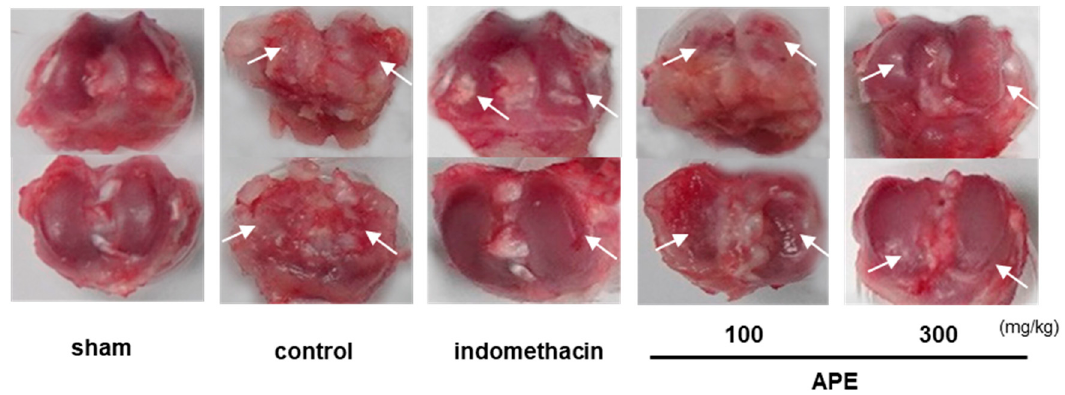
Figure 3. Photographic images of the knee joint cartilages of monosodium iodoacetate (MIA)-induced osteoarthritis rats. MIA rats were treated with indomethacin (3 mg / kg body weight) and Andrographis paniculata extract (100 and 300 mg / kg body weight).